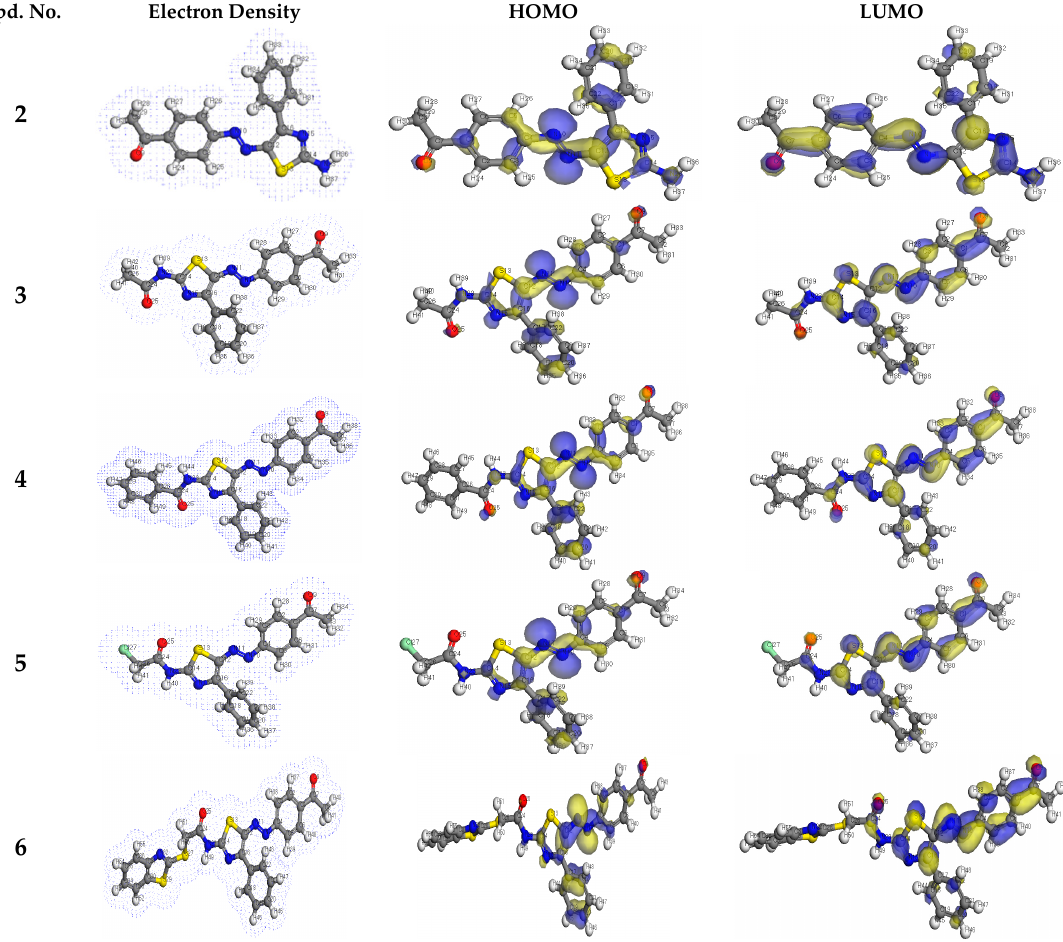
Figure 1. The electron density, the HOMO and LUMO frontier orbitals of 5-(4-acetylphenylazo) thiazoles 2 , 3 , 4 , 5 and 6 .